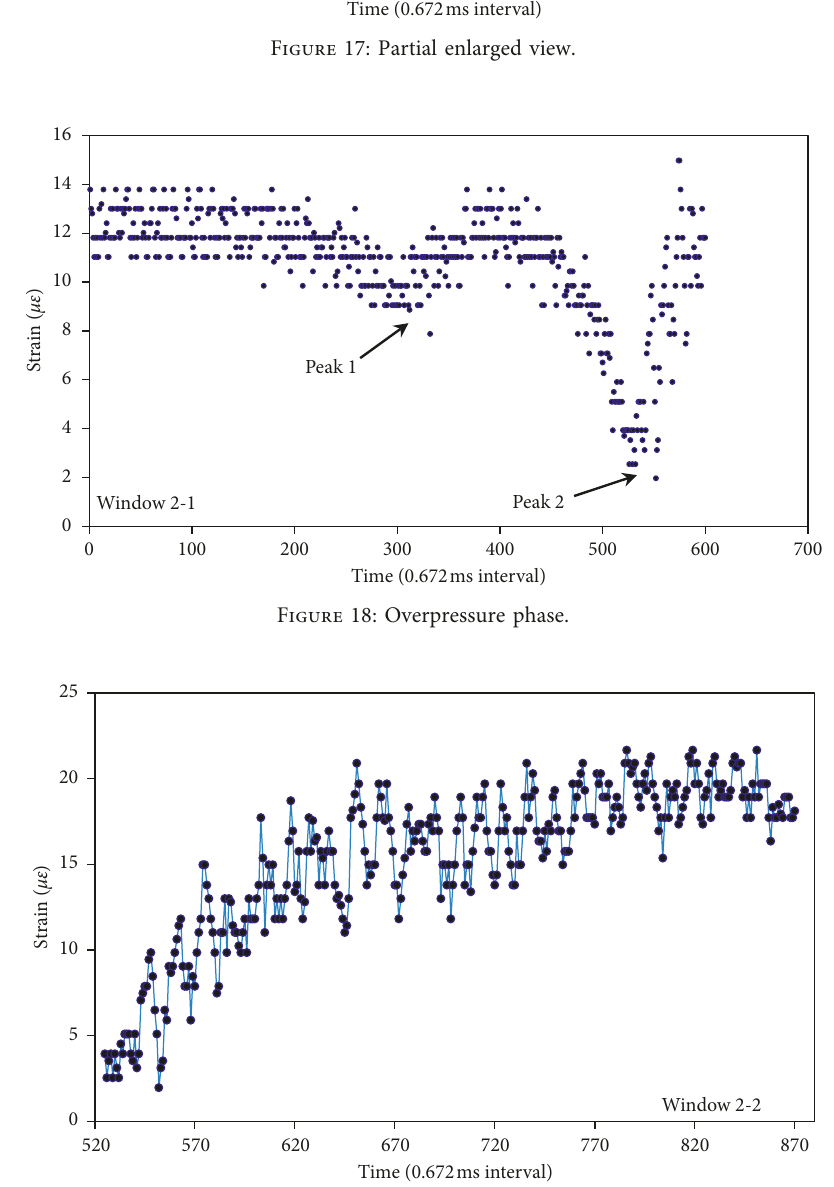
Figure 19: Vibration and temperature increase phase.